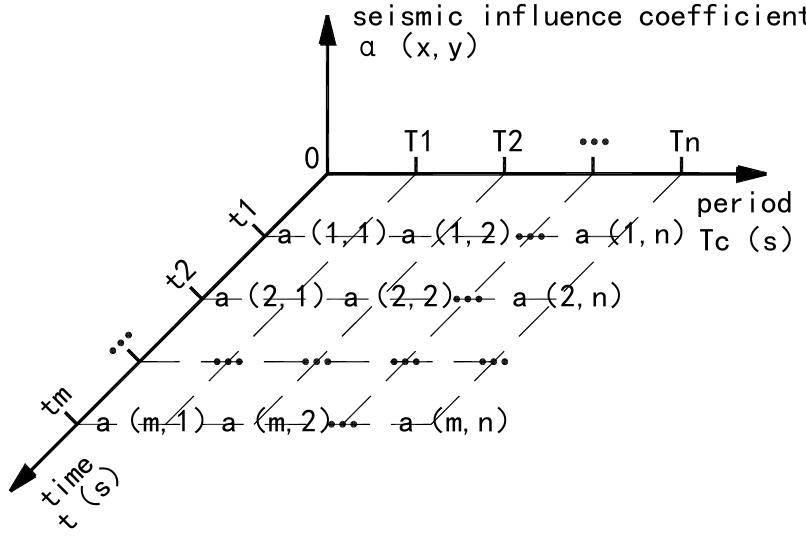
Figure 2. Time-domain spectrum of elastic seismic response.